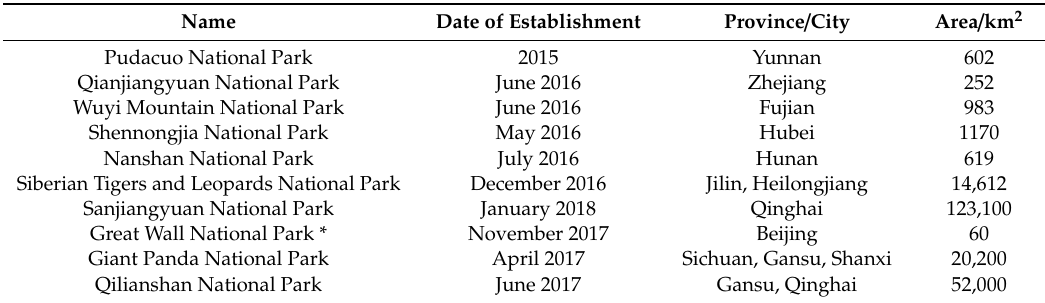
Table 3. Profile of the original 10 pilot national parks in